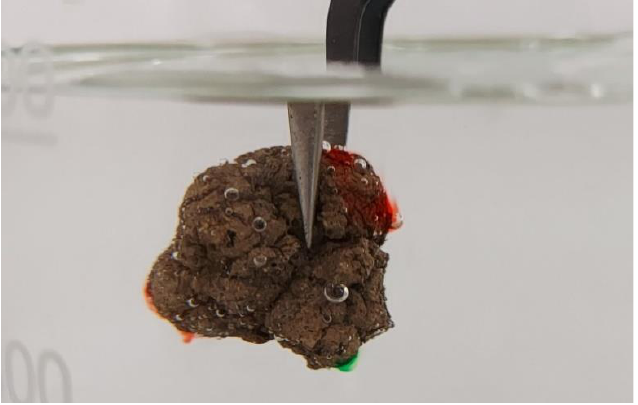
Figure 4. LECA grain immersed in water.